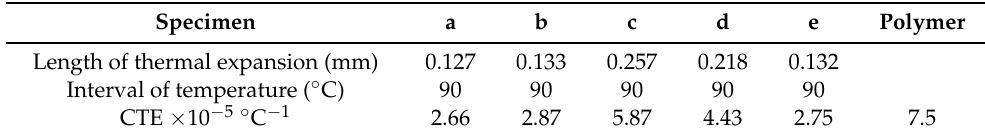
Table 2. Experimentally determined CTEs of five specimens.